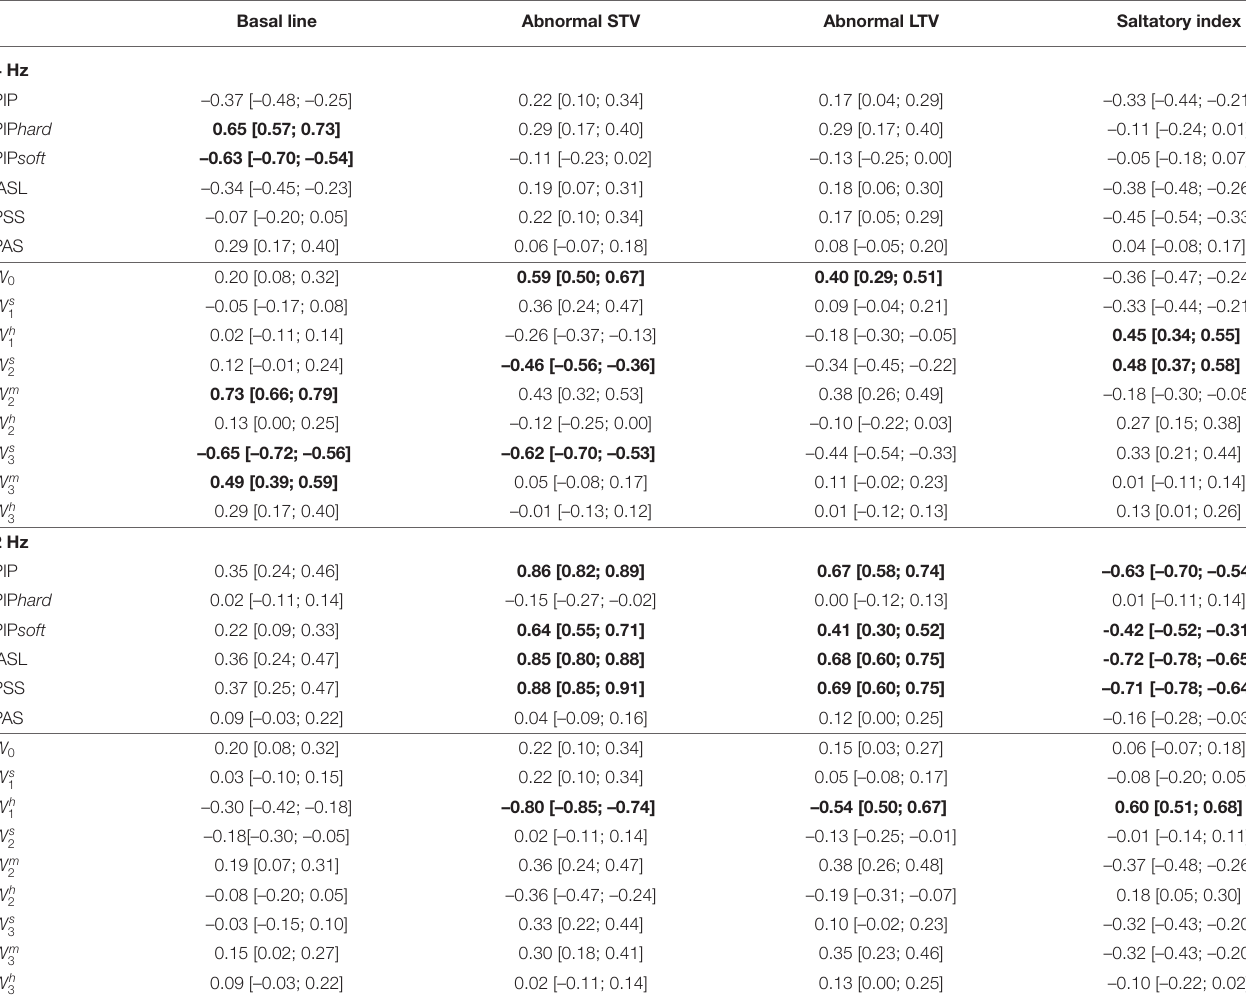
TABLE 3 | Spearman correlation, and corresponding 95% confidence intervals, between Sisporto clinical features, computing using 4 Hz fetal heart rate time series and fragmentation indices for the 4 and 2 Hz fetal heart rate time series. Basal